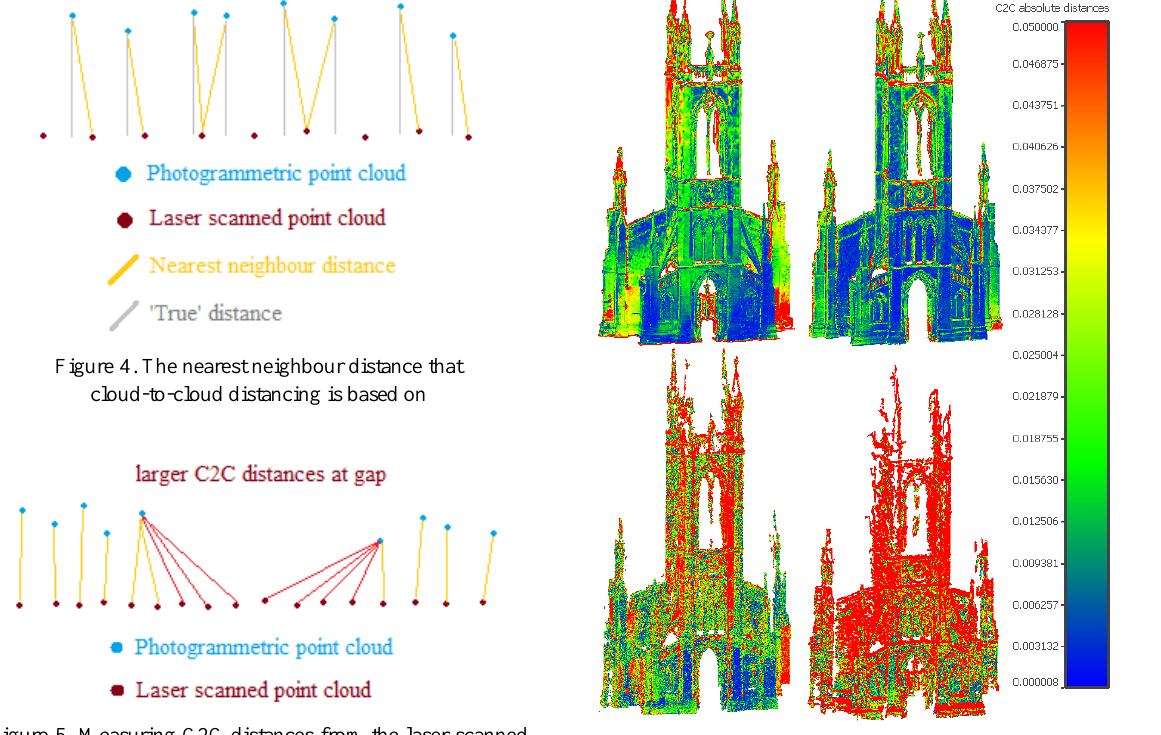
barely affected. C2C distances were all within 1mm,